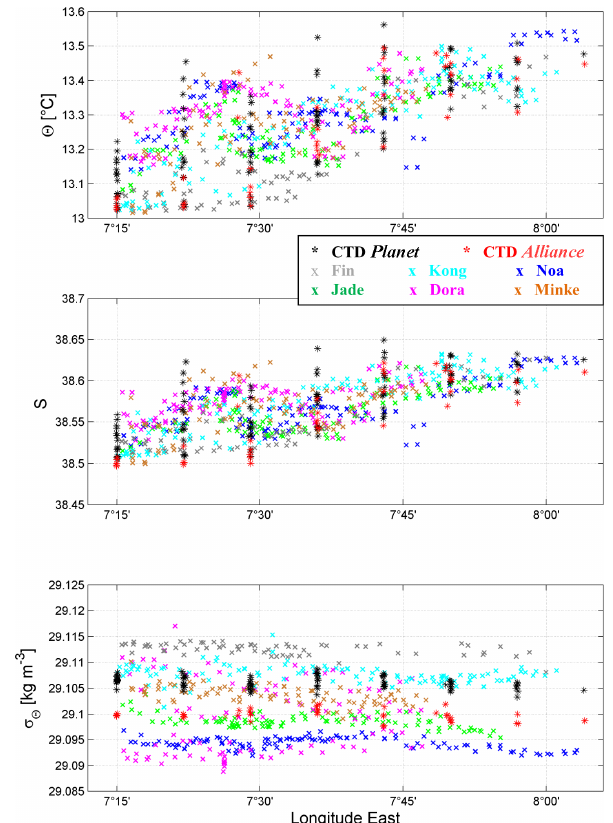
Figure 3. Potential temperature ( (cid:50)) , salinity ( S ), and potential den- sity anomaly ( σ (cid:50) ) at roughly 900dbar versus longitude of all CTD and glider profiles available at that pressure level. Planet covered all latitudes of the trial area, Alliance observed in the northern part, and the gliders surveyed at selected latitudes given in Fig.